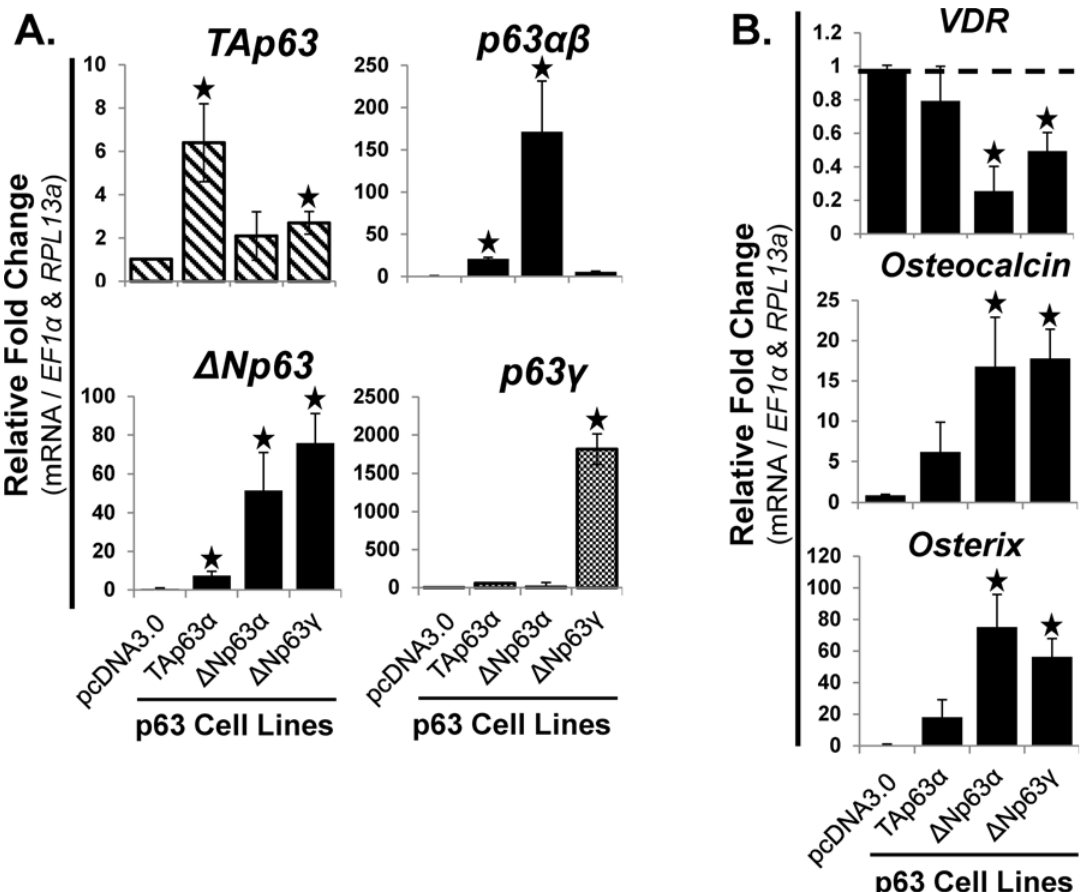
Fig 6. Stable overexpression of Δ Np63 α and Δ Np63 γ increased the mRNA expression of osteocalcin and osterix, and decreased VDR. hMSC were transfected with pcDNA3.0-p63 vectors (7 days), followed by selection with G418 (3 weeks). The cells were then expanded and cloned over 2 months. Overexpression of TAp63 β , TAp63 γ and Δ Np63 β caused a cell proliferation arrest; hence they were not available for long-term expansion and analysis. A) RT-qPCR analysis of p63 isoform (left panels, TA- and Δ Np63 ) and splice variant mRNA (right panels, p63 α / β and p63 γ ) expression. RT-qPCR analysis demonstrated the relative level of overexpression of each of the p63 variants compared to empty vector (pcDNA3.0). B) RT-qPCR analysis of mRNA expression of osteoblastic differentiation markers: VDR (vitamin D 3 receptor (binds 1 α ,25-dihydroxyvitamin D 3 )), Osteocalcin , and Osterix . Also of note, the overexpression of TAp63 α , Δ Np63 α , and Δ Np63 γ did not alter the mRNA expression of runx2 , osteopontin or the late stage osteoblastic gene, BSP . N = 3 independent experiments in triplicate. ( * ) p (cid:1) 0.05 compared to control (hMSC with empty vector, pcDNA3.0). hMSC used were from a 22 year old